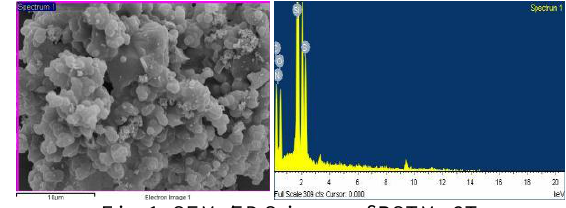
Table 1. EDS composition of PSTM-3T